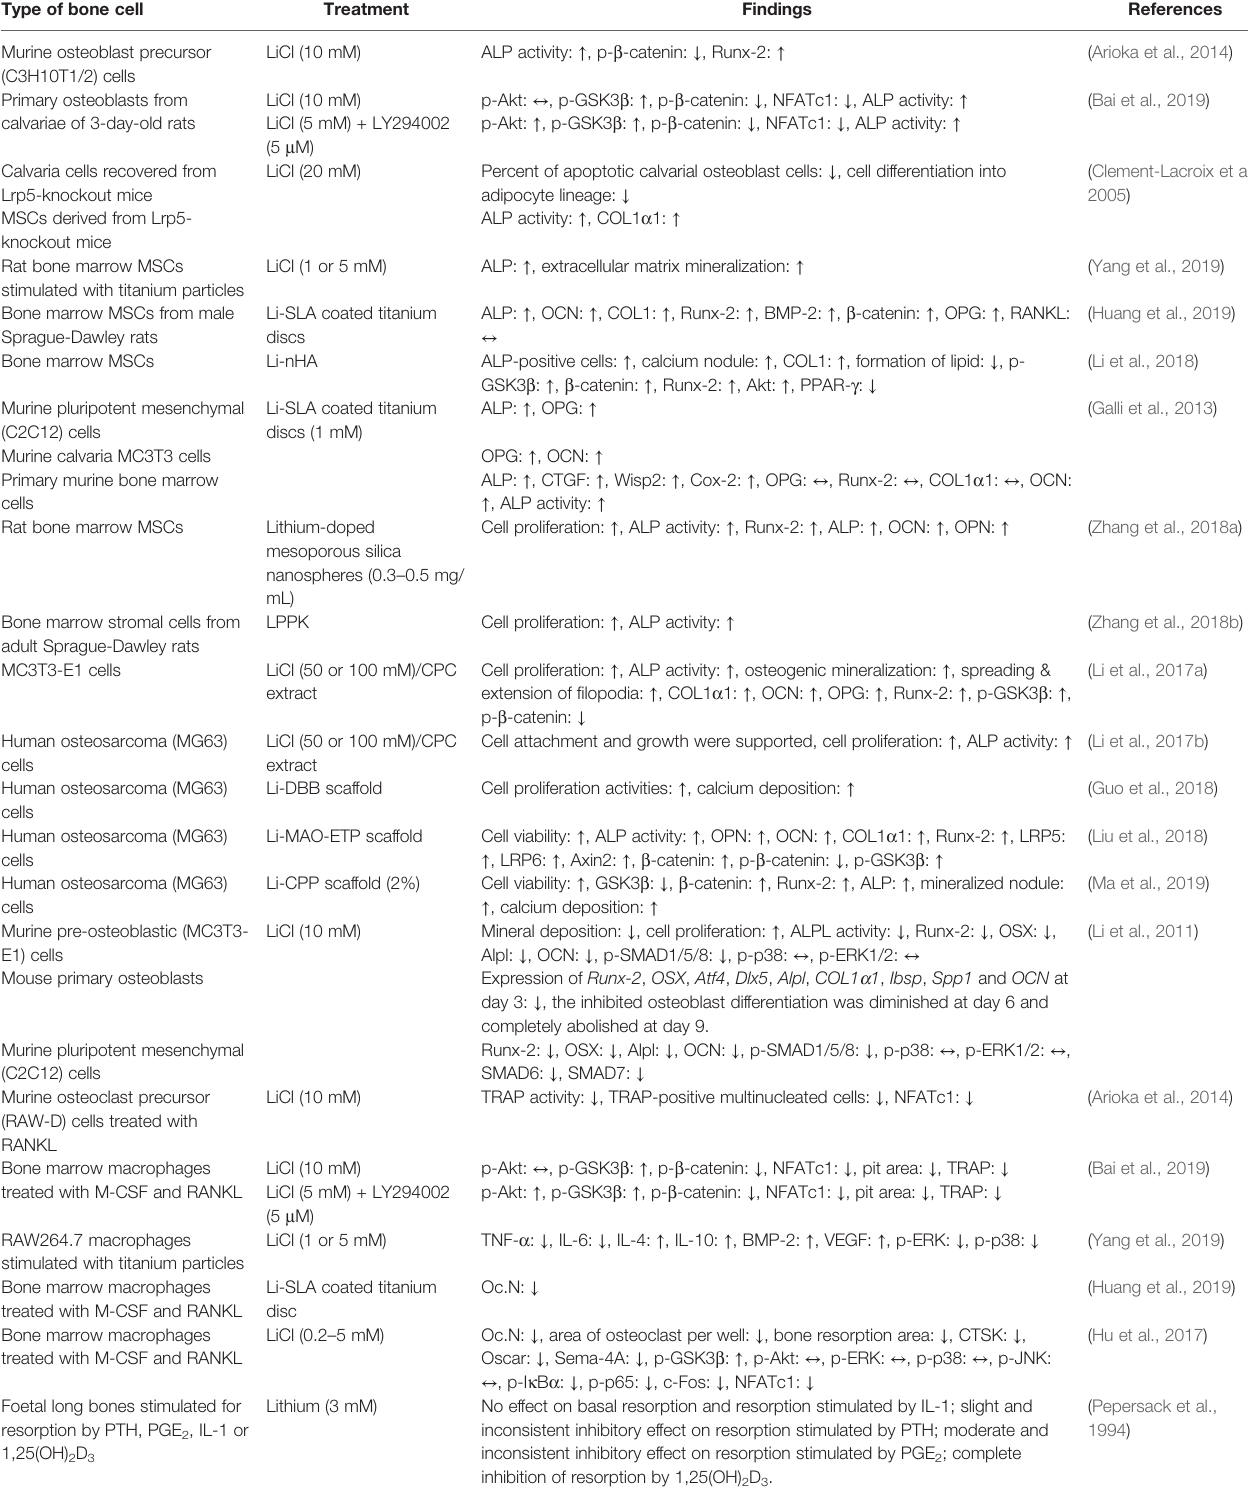
TABLE 3 | Effects of lithium on bone cells in vitro